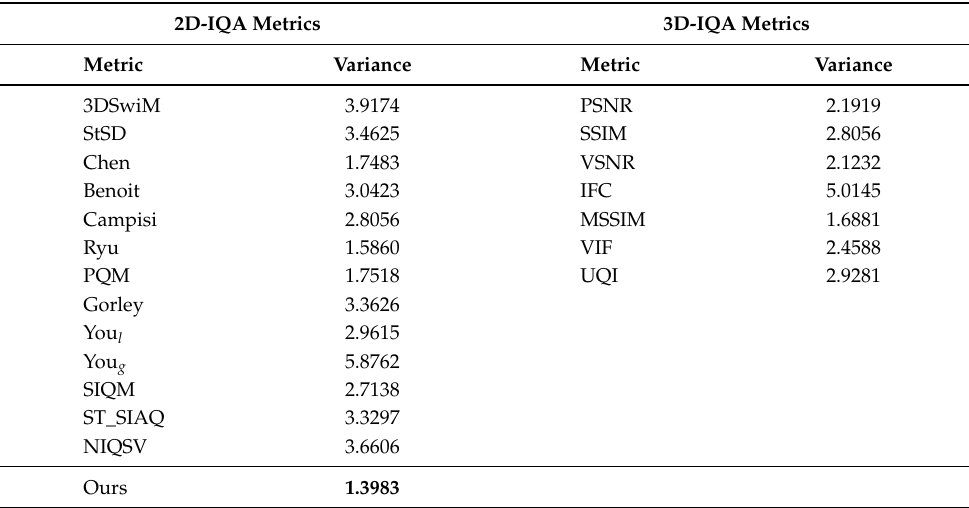
Table 5. Variance of the residuals of subjective ratings and the mapped objective scores of the proposed and the compared 2D and 3D quality metrics. The best results are highlighted in